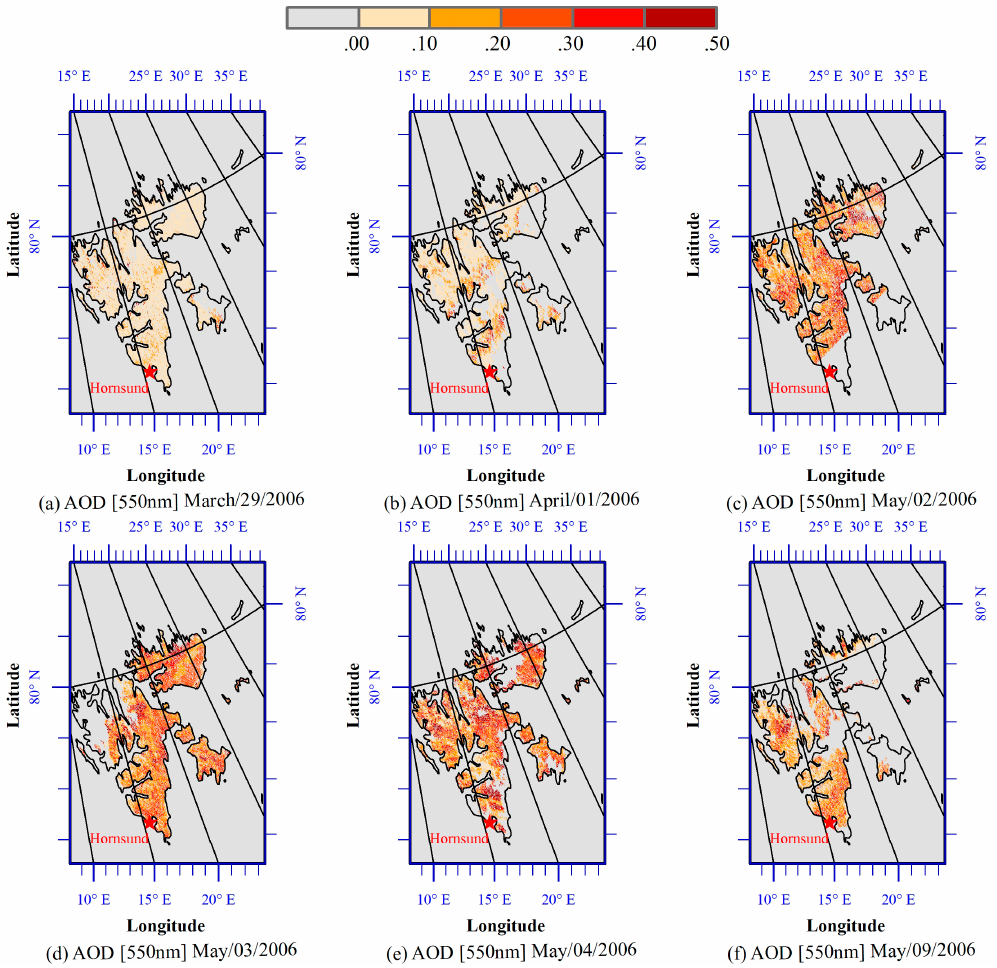
Figure 2. Advanced along-track scanning radiometer (AATSR) derived aerosol optical depth (AOD) at 550 nm for a haze event reported in Stohl et al. (2007) for selected days before, during and after the haze event: ( a ) 29 March, ( b ) 1 April, ( c ) 2 May, ( d ) 3 May, ( e ) 4 May, and ( f ) 9 May.